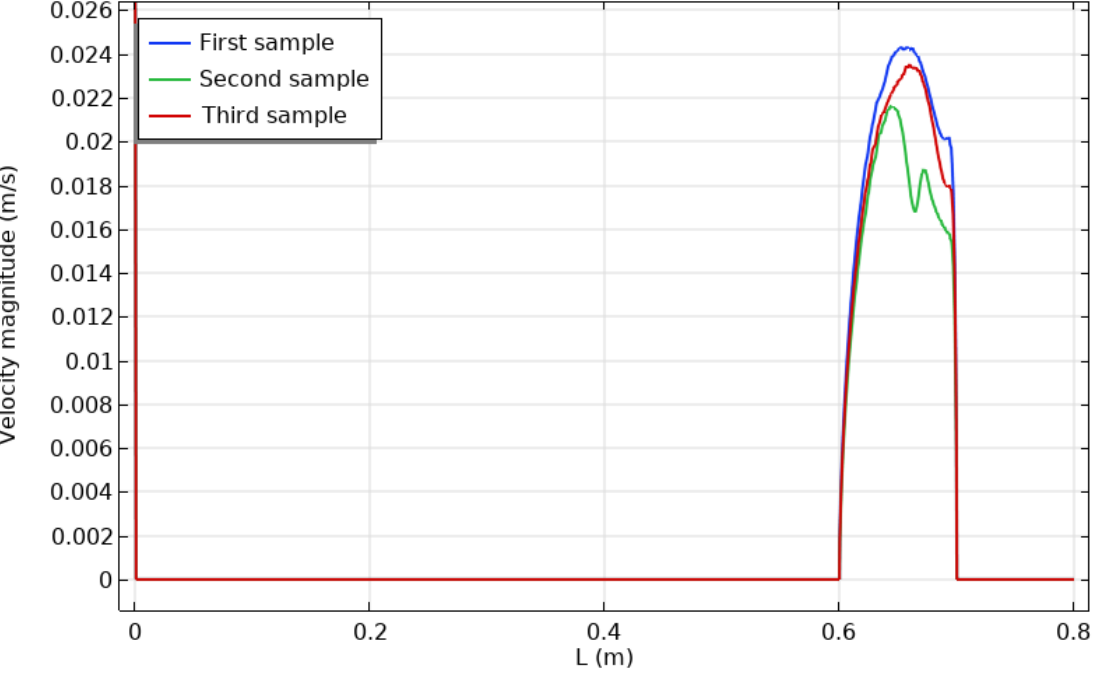
Figure 14. Local velocity distribution in the channel–enclosure assembly .